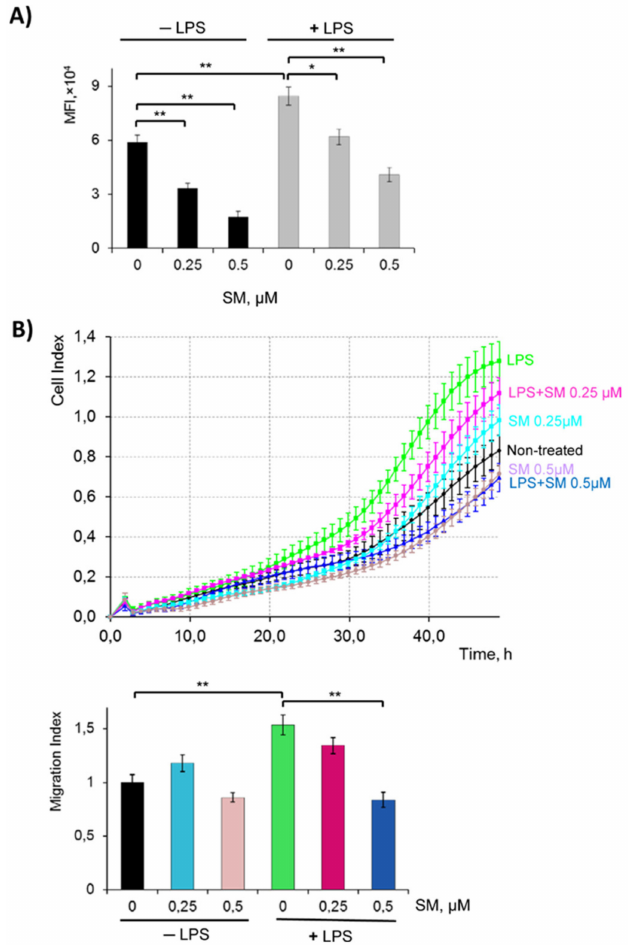
Figure 4. E ff ect of SM on phagocytosis ( A ) and migration dynamics ( B ) of RAW 264.7 cells. ( A ) Phagocytic ability was estimated using FITC–dextran (1 mg / mL). Uptake was assessed by flow cytometry. ( B ) For migration, RAW 264.7 cells were seeded in CIM plates and incubated with SM (0.5 or 0.25 µ M), LPS (1 µ g / mL) or SM + LPS, and migration was monitored continuously from the upper to lower chamber, indicated by the cell index (CI). Upper panel, representative trace from the RTCA-DP software showing macrophage migration toward the lower chamber; lower panel, Migration Index value after 48 h of incubation calculated as described in the Section 4. * p < 0.05, ** p <